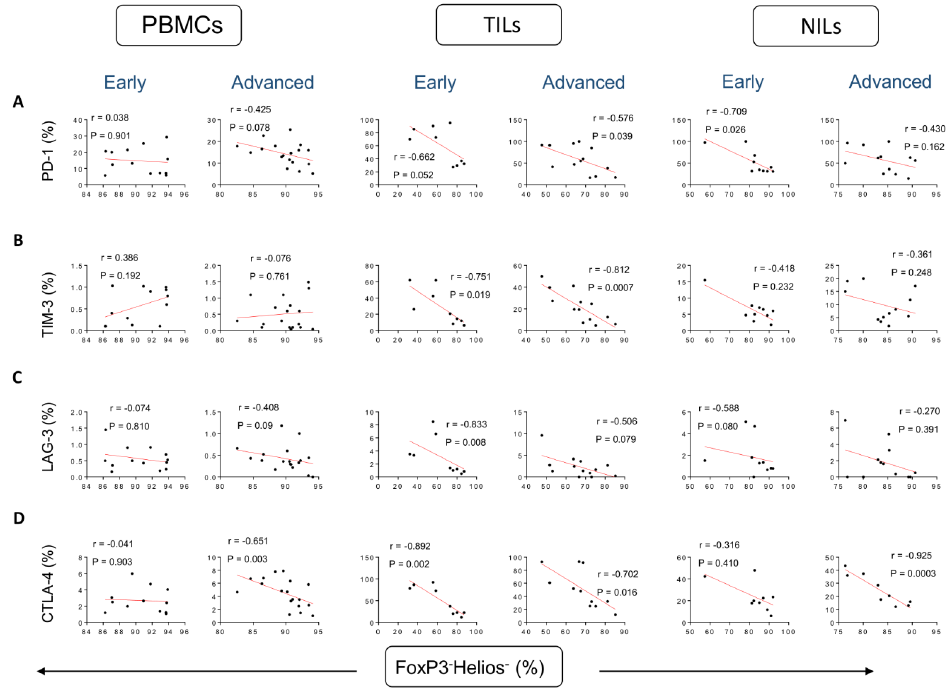
Figure 4. Correlations between frequencies of FoxP3 − Helios − and immune checkpoints in CD4 + T cells in CRC patients based on disease stages. Correlations between frequencies of CD4 + FoxP3 − Helios − Tregs with PD-1 + ( A ), TIM-3 + ( B ), LAG-3 + ( C ), and CTLA-4 + ( D ) in PBMCs, TILs, and NILs in CRC patients with early and advanced stages.